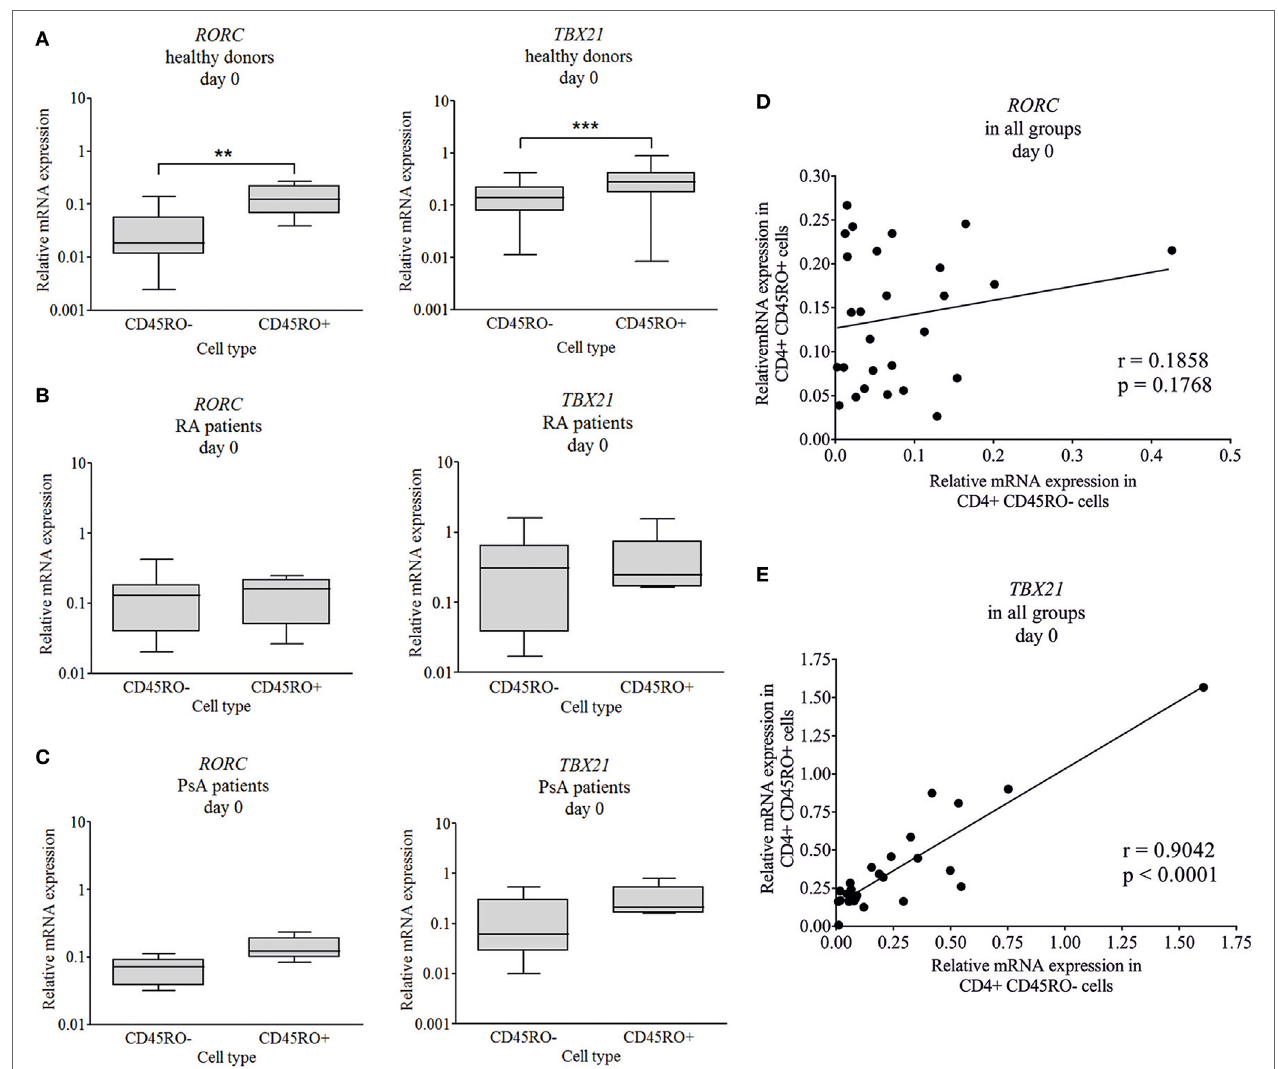
FigUre 1 | Baseline RORC and TBX21 transcription factor expression in naive and memory cells. CD4 + CD45RO − naive and CD4 + CD45RO + memory T cells were isolated by magnetic separation from peripherial blood mononuclear cells of healthy volunteers ( n = 11), rheumatoid arthritis (RA) ( n = 10), and psoriatic arthritis (PsA) patients ( n = 5). Total RNA was isolated and the gene expressions were measured by quantitative real-time PCR. Healthy donors’ (a) , RA (B) , and PsA patients’ (c) data are shown in a logarithmic scale; median, minimum, and maximum of the relative gene expression levels are indicated (Wilcoxon signed rank test ** p < 0.01; *** p < 0.001). Correlations (Pearson correlation) are shown between the RORC (D) and TBX21 (e) expression in naive and memory T